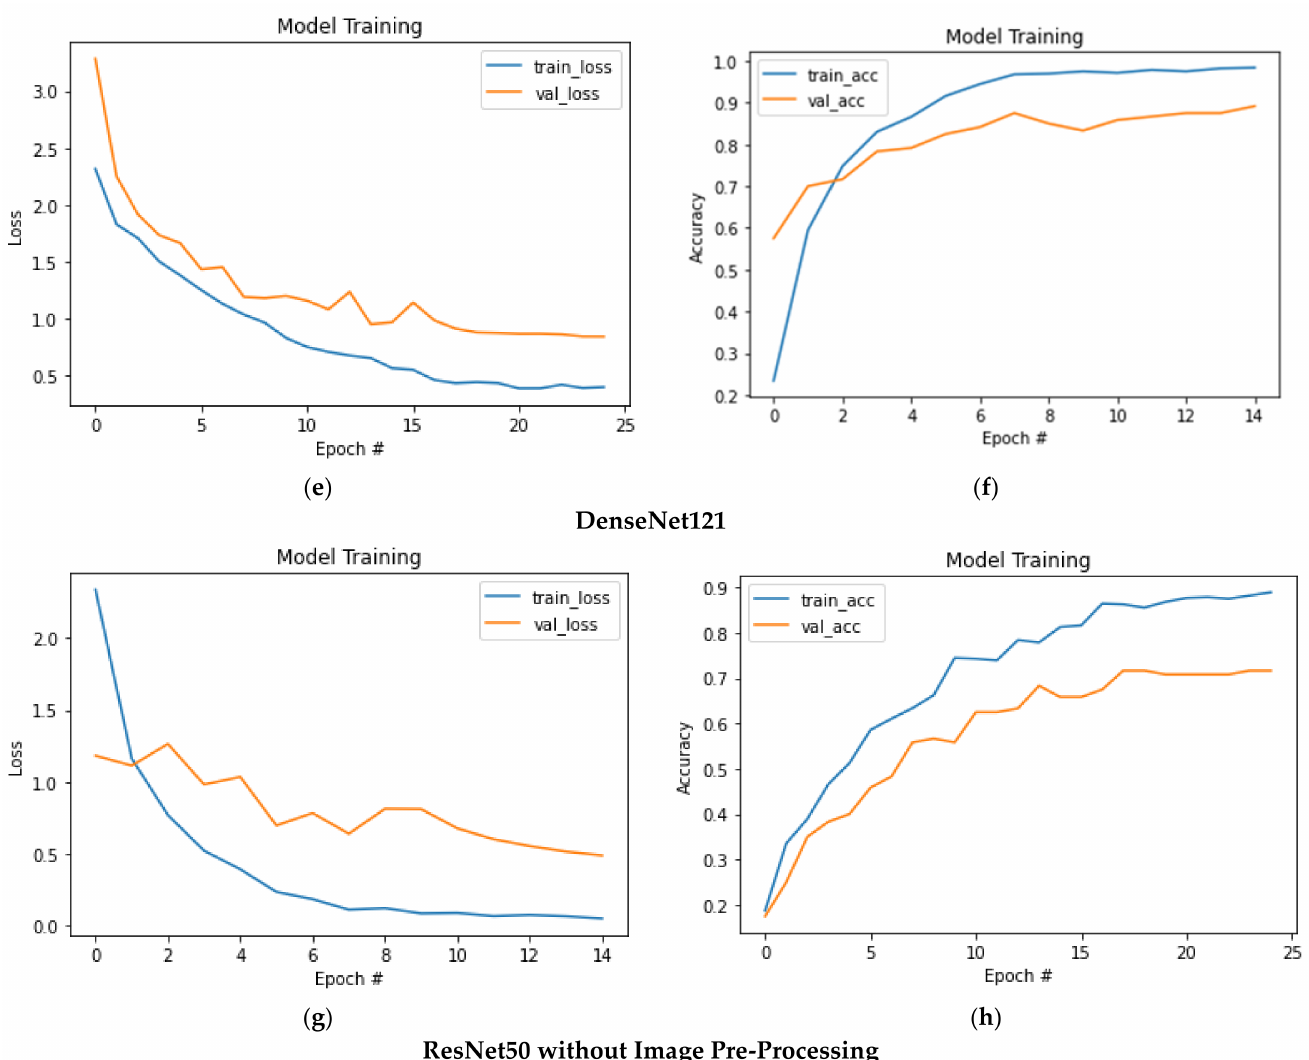
Figure 8. ( a – h ). Plots for learning curves for the different convolutional neural networks